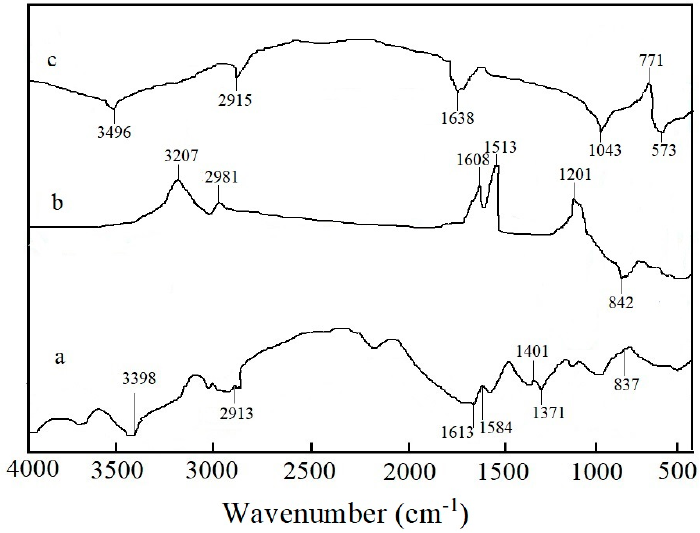
Figure 4. FTIR images of chitosan ( a ), activated Biochar ( b ), and cross-linked magnetic chitosan/activated biochar (CMCAB) ( c ).